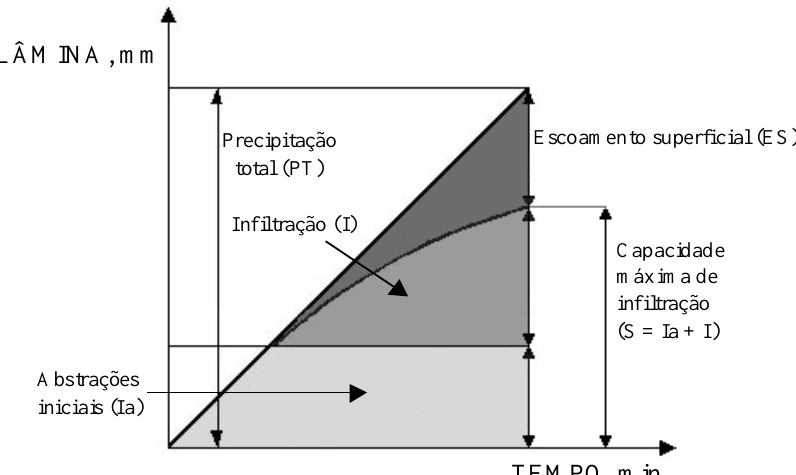
Figura 1. Componentes associados ao método do número da curva, sugerido pelo serviço de conservação de solo do Departamento de Agricultura dos Estados Unidos